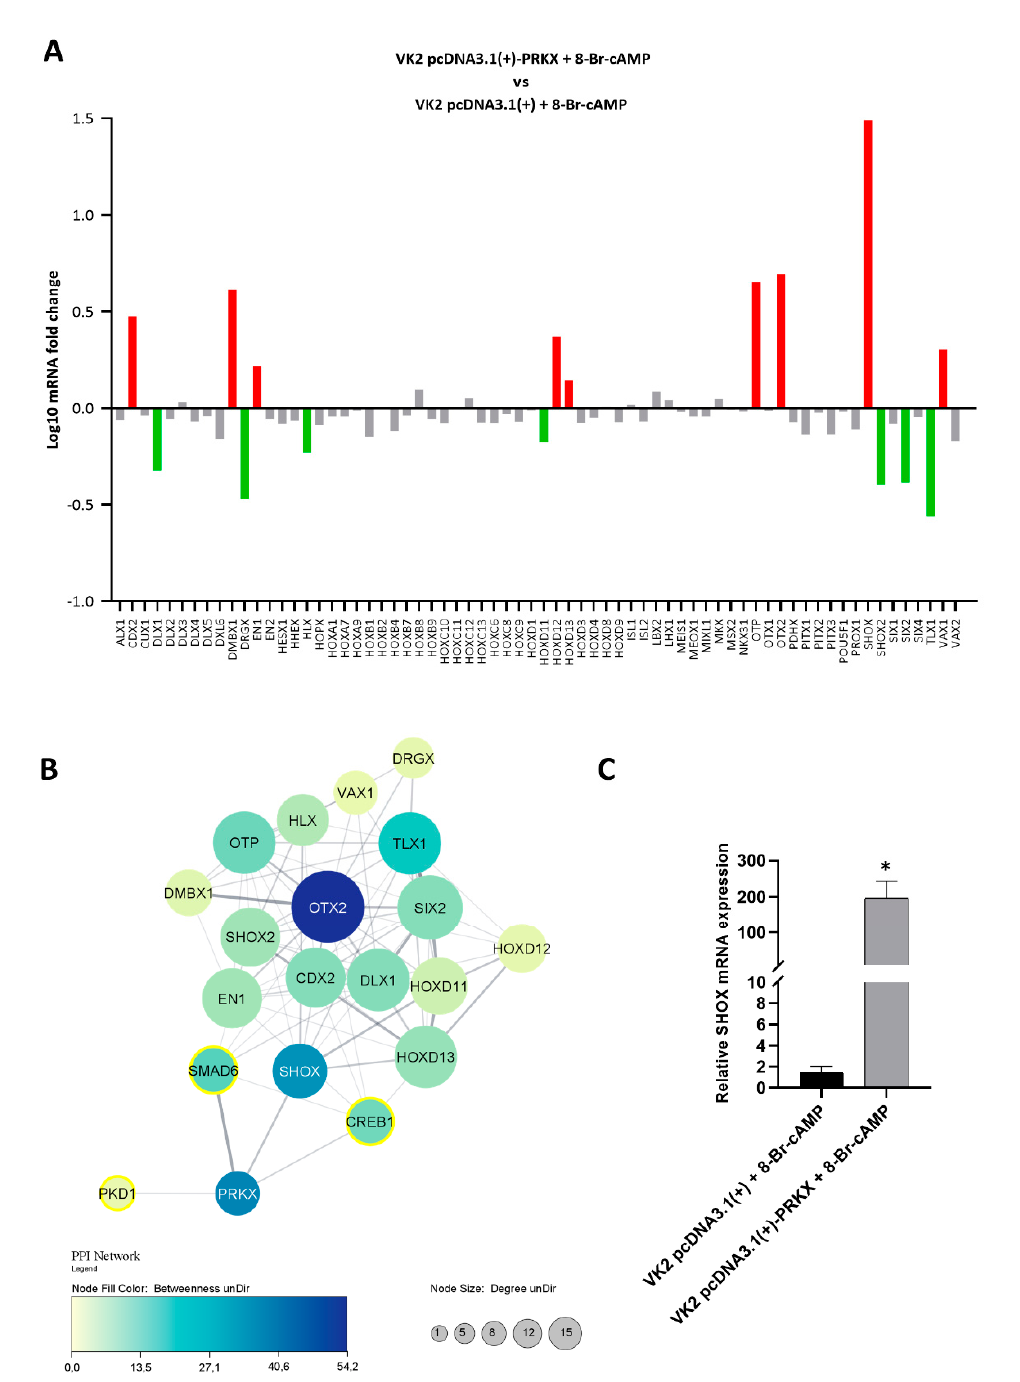
Figure 6. PRKX overexpression influences the expression of HOX genes in VK2 E6/E7 cells. ( A ) Recapitulating graph of RT-qPCR screening for HOX gene mRNA level alterations in VK2 E6/E7 cells transfected with pcDNA3.1(+)-PRKX after 8-Br-cAMP treatment. Relative fold changes represented on a log10 scale are referred to as VK2 E6/E7 cells transfected with empty vector as the baseline. Gene expression variation was considered significant for fold changes ≤ 0.6 and ≥ 1.3. Significantly upregulated and downregulated genes are indicated as red and green columns, respectively. ( B ) PPI network showing interactions between PRKX, its principal downstream substrates SMAD6, CREB1, PKD1, and HOX genes’ products that were deregulated from the RT-qPCR array analysis. Node size is directly proportional to connectivity degree and node colour is correlated to betweenness value, with a darker colour corresponding to a higher value. PRKX substrates are circled in yellow. ( C ) RT-qPCR analysis showing SHOX mRNA levels in VK2 E6/E7 transfected with PRKX expression vector (pcDNA3.1(+)-PRKX) or empty vector as control (pcDNA3.1(+)) and treated with 8-Br-cAMP (mean ± SD; n = 2; * p <